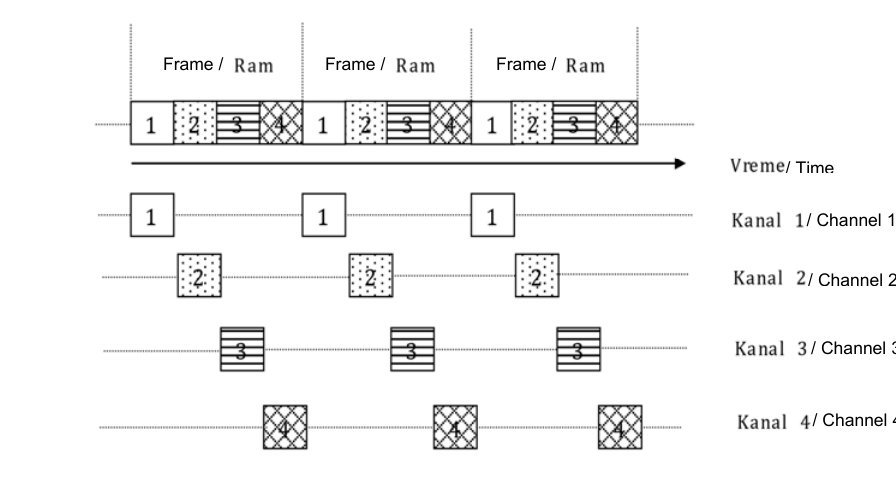
Figure 6 – Connection between time slots and communication channels in the TETRA TDM primary frame (123seminarsonly, 2004) Рис . 6 – Связь между временными интервалами и каналами связи в